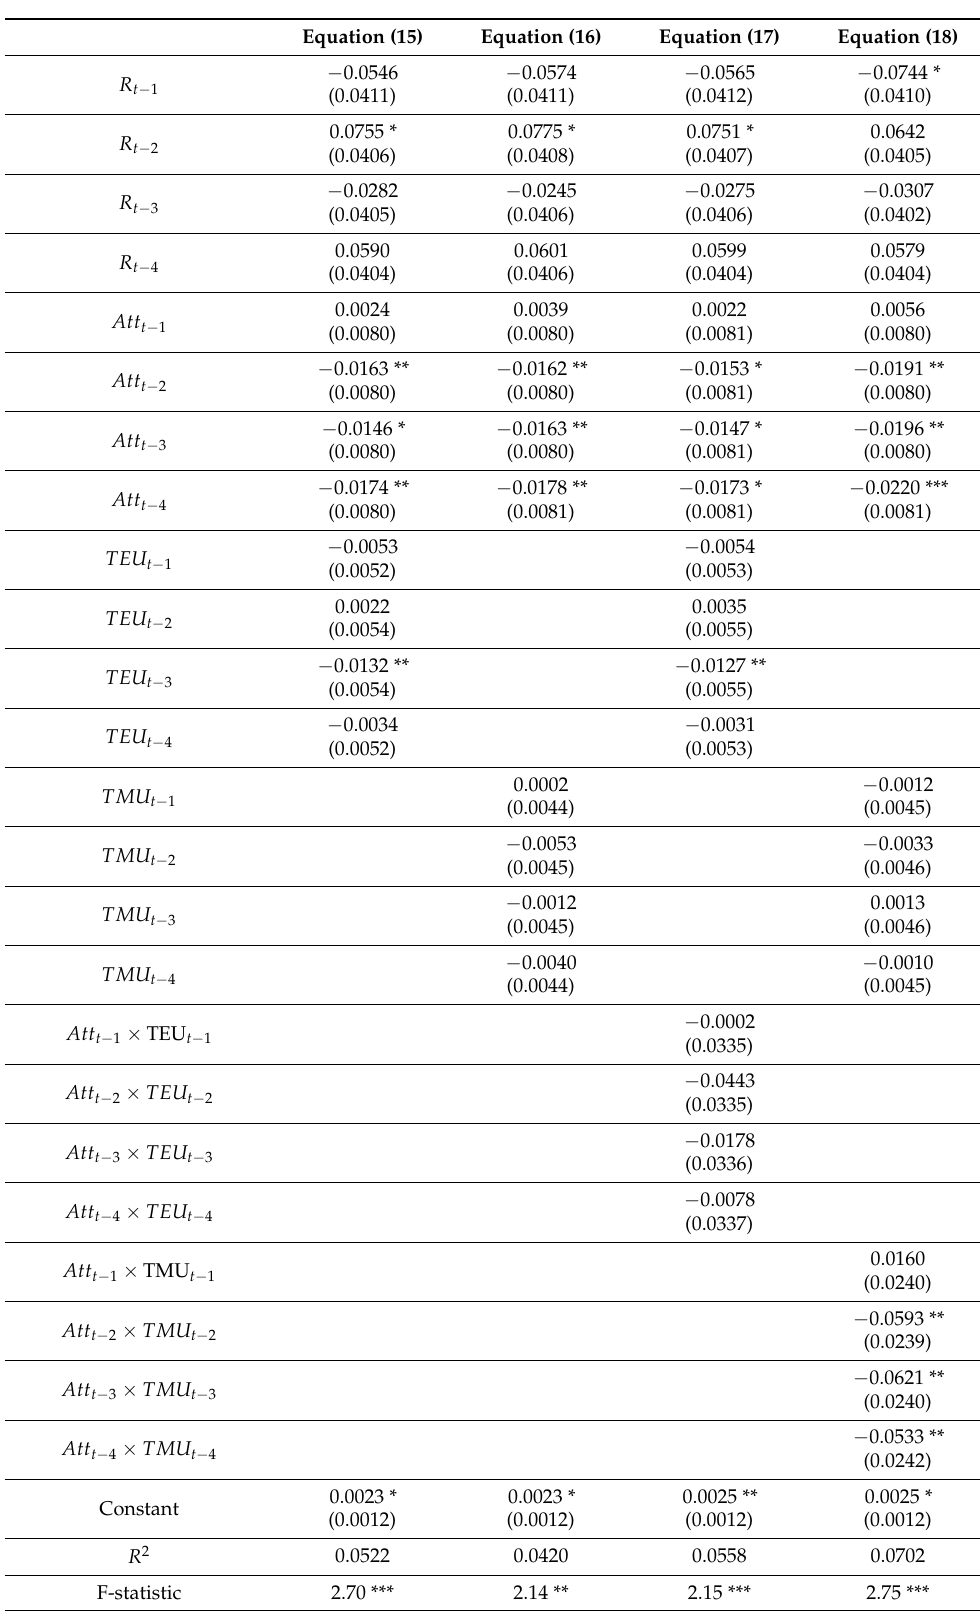
Table 13. Estimation results for controlling Twitter-based